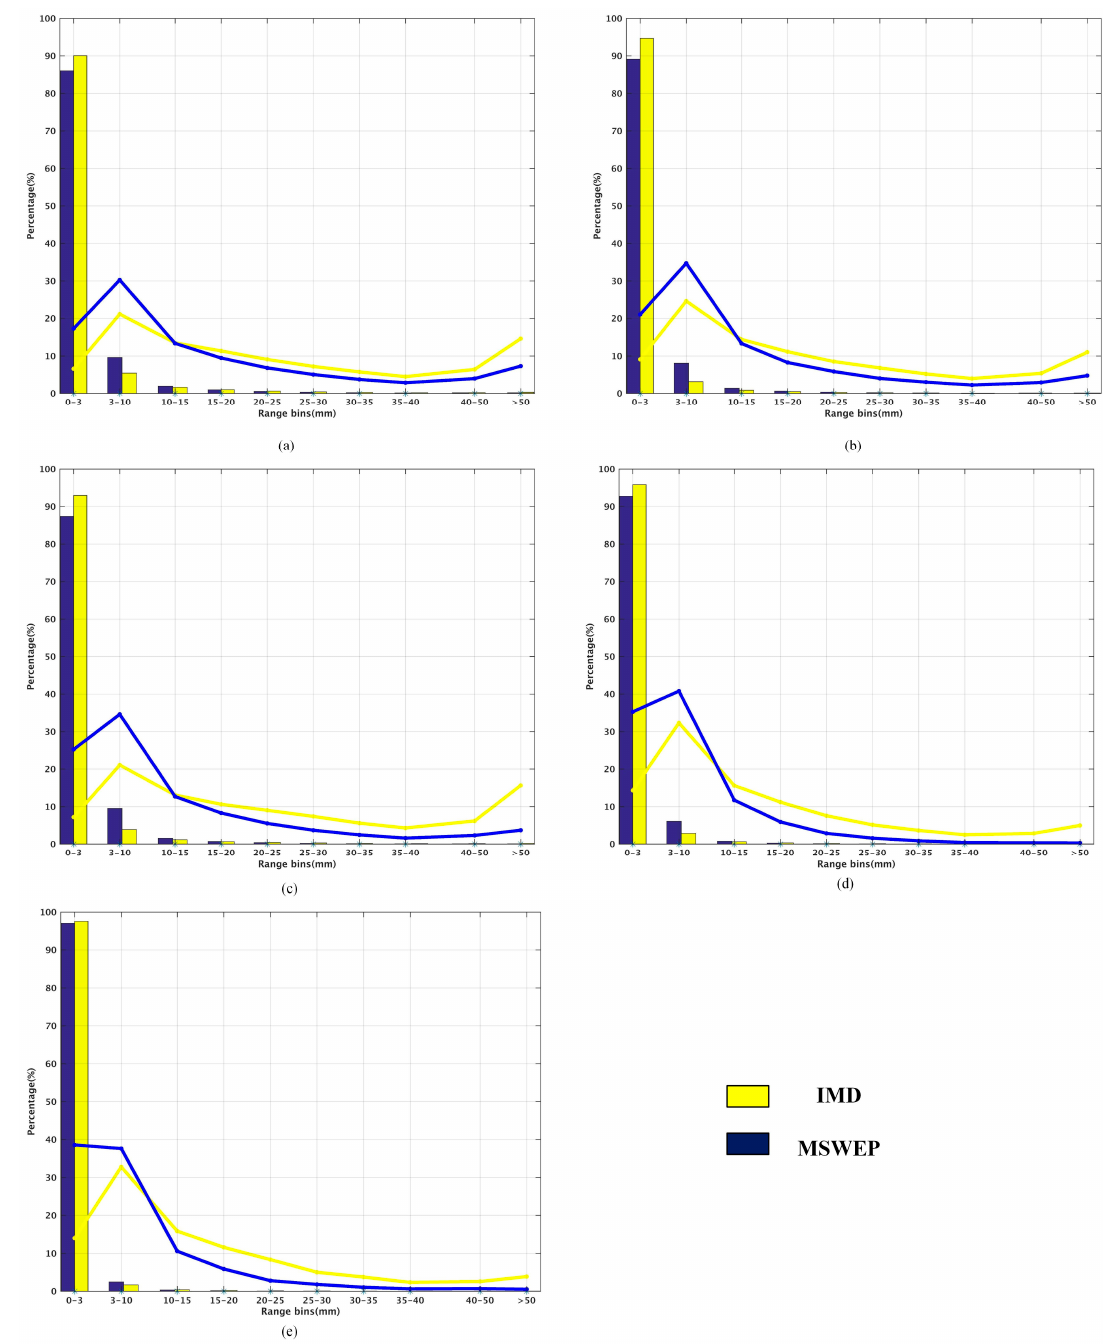
Figure 5. Distribution of daily rainfall in different rainfall classes and their relative contributions to the total rainfall in different grids for the pre-monsoon season (March, April, May) (MAM): ( a ) all